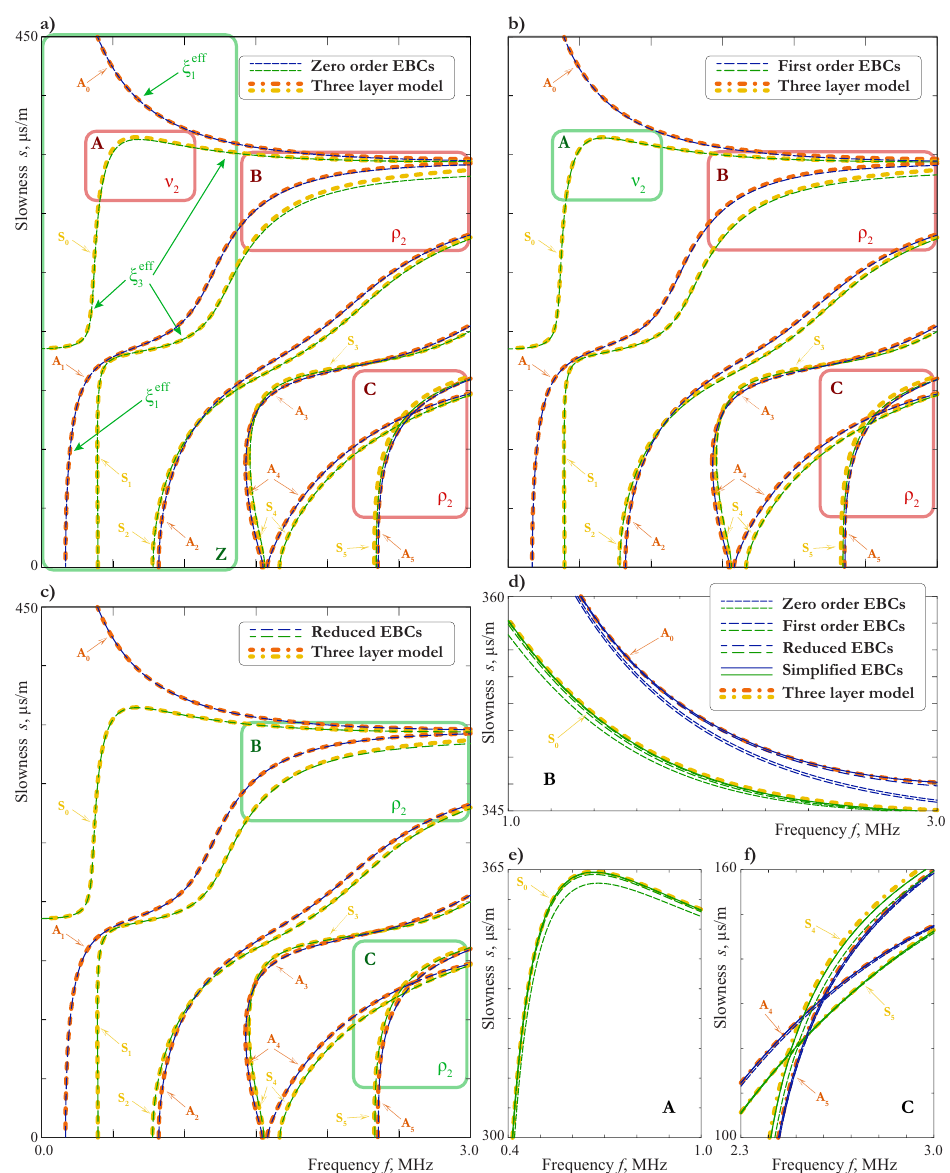
Figure 12. Slownesses of LWs propagating in 4.05 mm thickness plate (2 mm aluminium/50 µ m film/2 mm aluminium) for different approximations of EBCs: ( a )—zero-order EBCs (48), ( b )—first order EBCs (47), ( c )—reduced EBCs (46); ( d – f )—zoomed regions B, A and C from subplots ( a – c